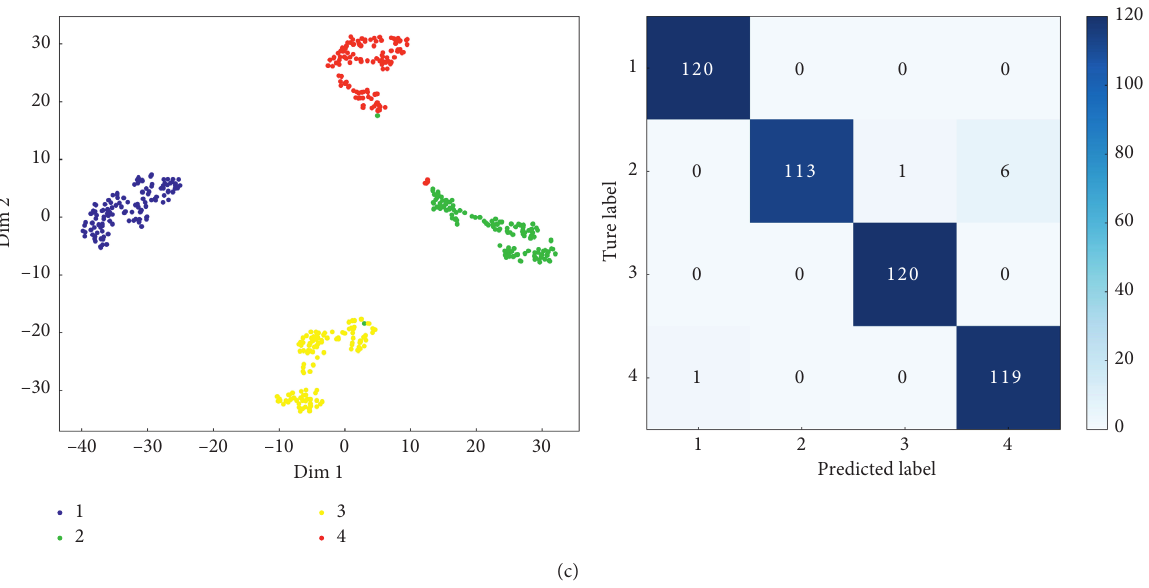
Figure 10: Visualization of the learned features and confusion matrixes in three transfer tasks: (a) A ⟶ B; (b) A ⟶ C; (c) A ⟶